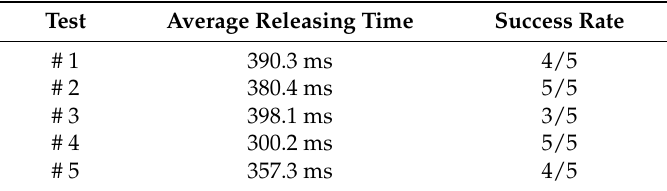
Table 2. Releasing time and success rate.